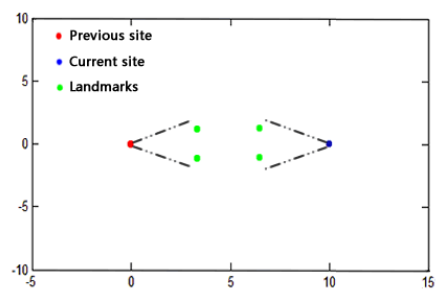
Figure 3. Distribution of landmarks in forward-backward capture